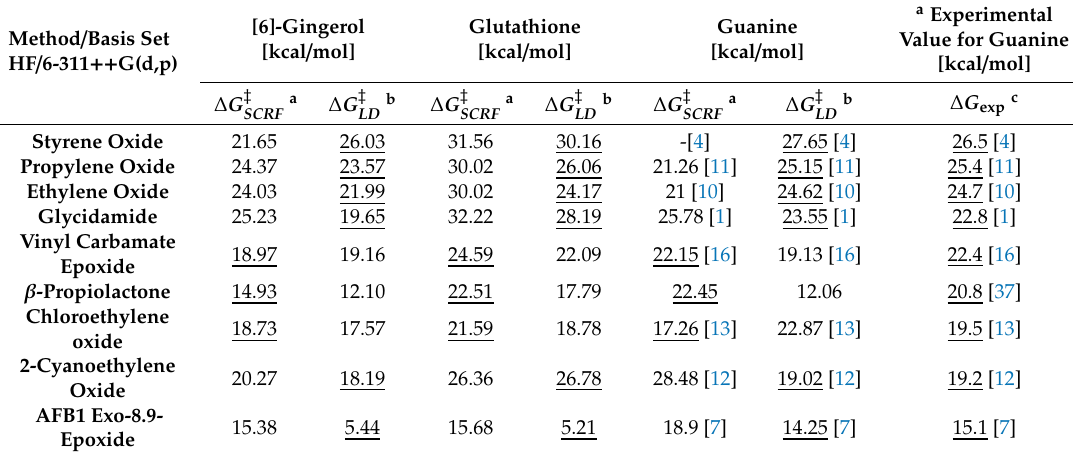
Table 2. Activation free energies for alkylation reactions of the studied chemical carcinogens with [6]-gingerol, glutathione and guanine obtained by the SCRF and LD implicit solvation models at the HF / 6-311 ++ G(d,p) level of